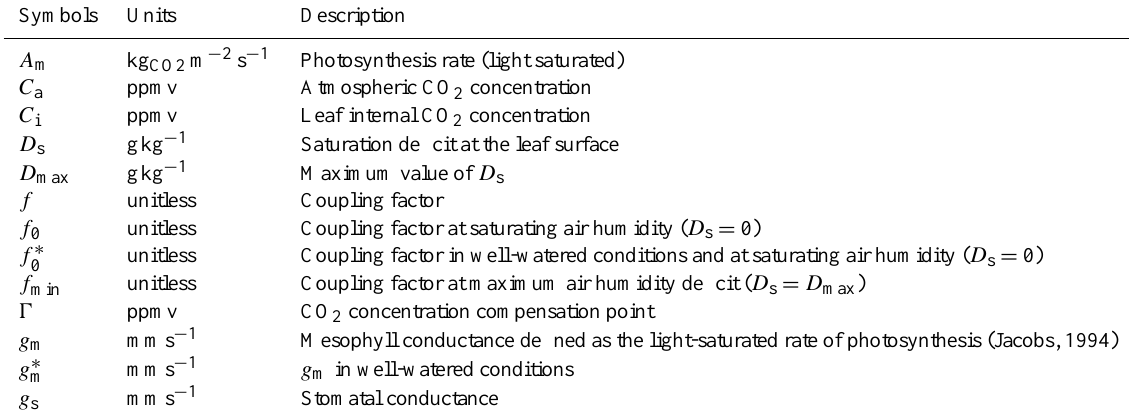
Table 2. ISBA CC : nomenclature. Symbols Units